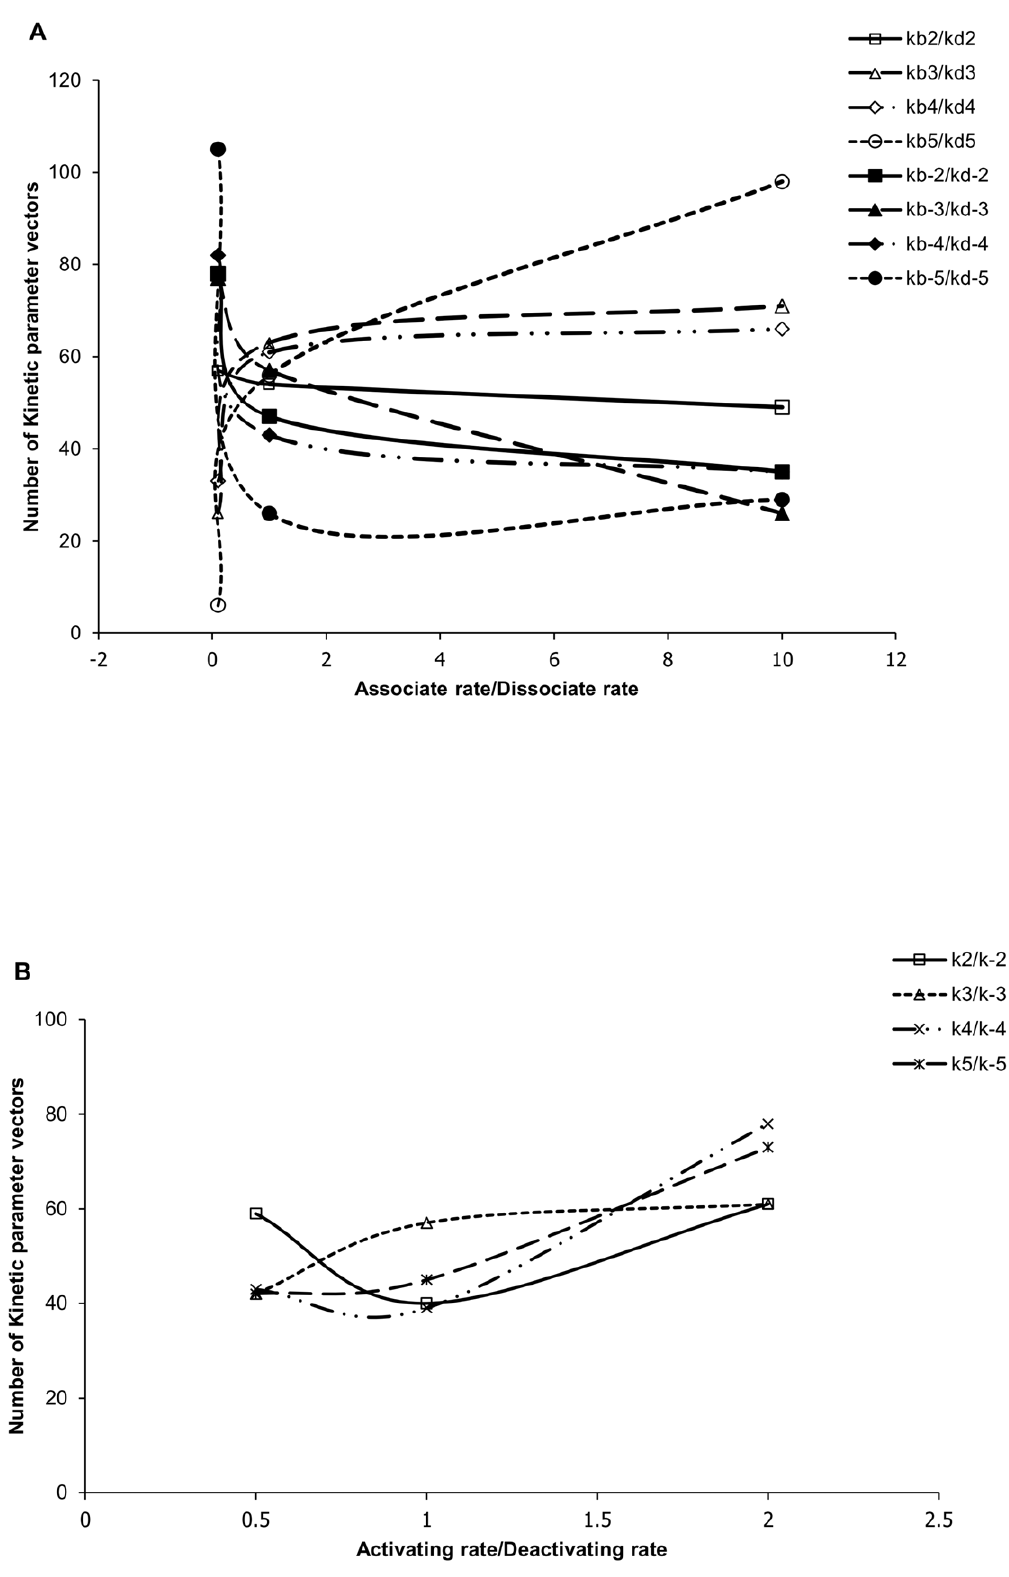
Figure 3. Number of kinetic parameter vectors (vertical axis) that, when combined with 36 concentration vectors, lead to responsive models in more than 30 cases. The total 160 kinetic parameter vectors are grouped by different ratios (horizontal axis) of (a) various association rates (kbN and kb-N) over the corresponding dissociation rates (kdN and kd-N), and (b) various activation rates (kN) over the corresponding deactivation rate (k-N).